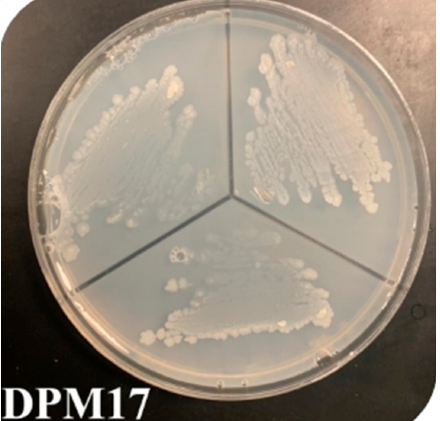
Figure 2. The evolutionary relationships of DPM17 and closely related bacterial species.